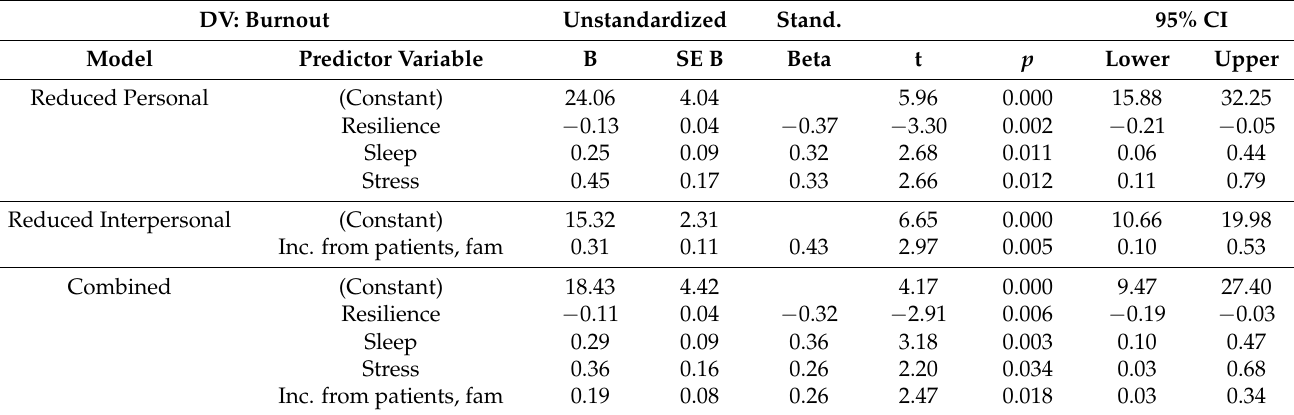
Table 3. Results of backward elimination linear regression evaluating variance in burnout for Models 1 (individual variables), 2 (interpersonal variables), and 3 (combined). Inc. = incivility.